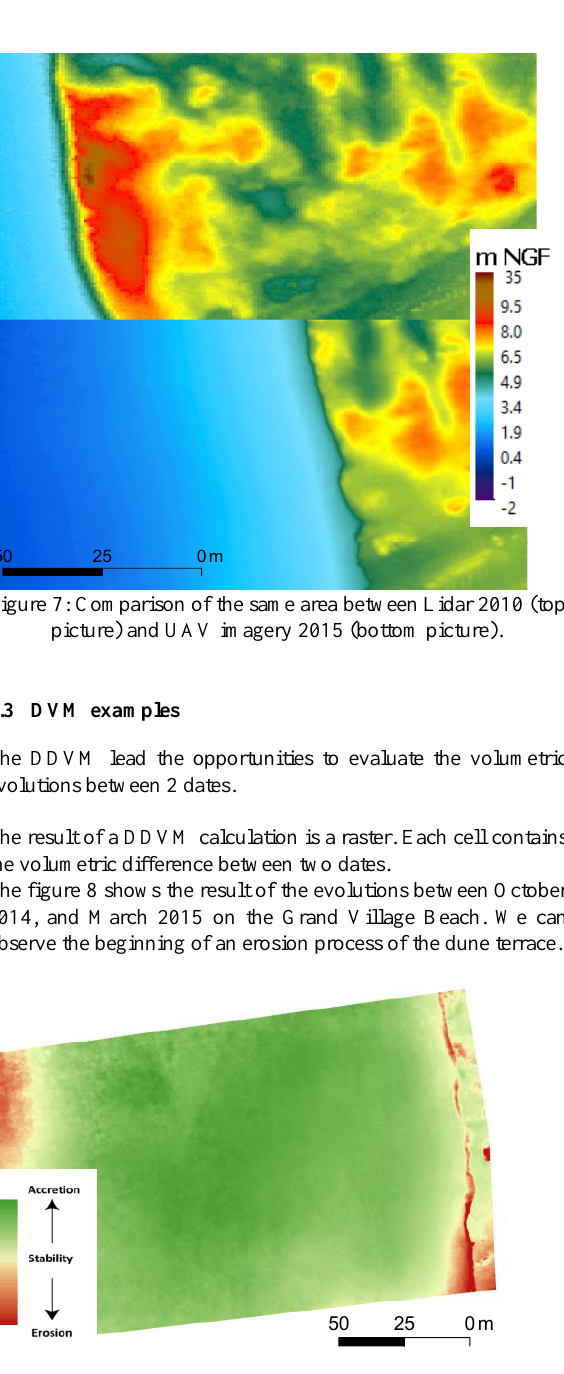
Figure 8: Example of a DDVM without any polygon